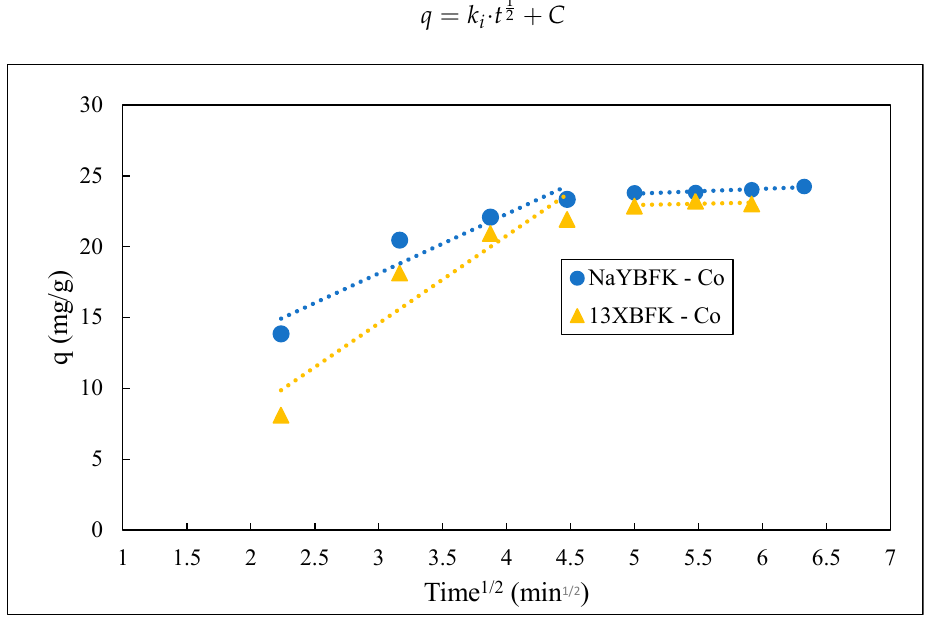
Figure 6. Webber-Morris plot for Co 2+ adsorption at 298 K. Conditions: 5 g/L of adsorbent dosage, 1100 rpm, and 40 mg/L of initial Co 2+ concentration.